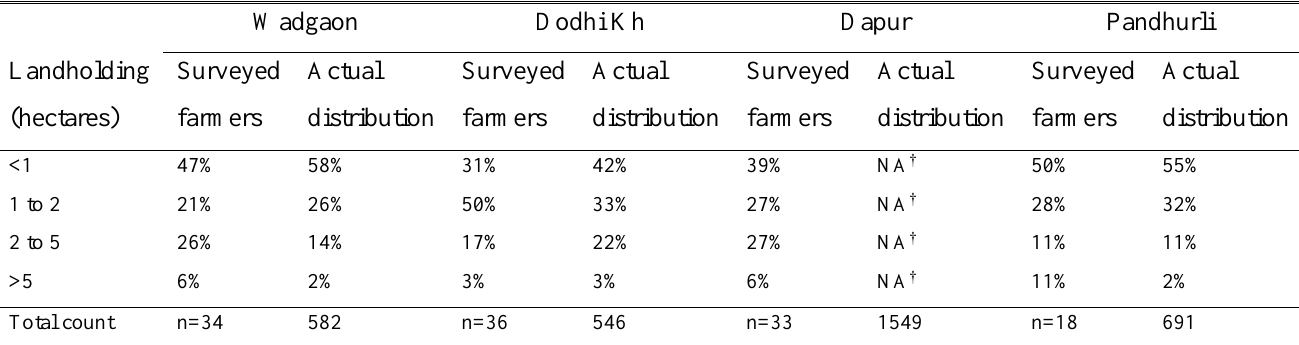
Table A3.1. Sample distribution by landholding category compared to actual landholding distribution as obtained from respective village revenue